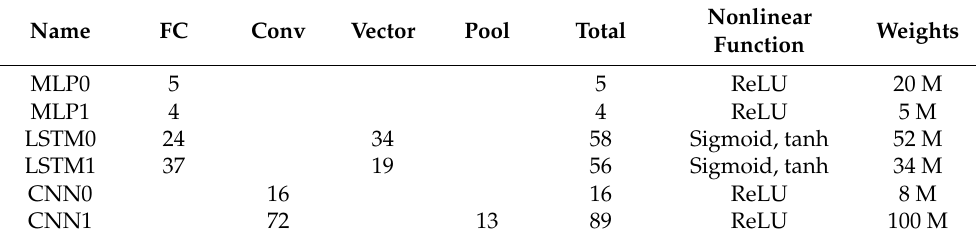
Table 9. Description of some DNN models and their